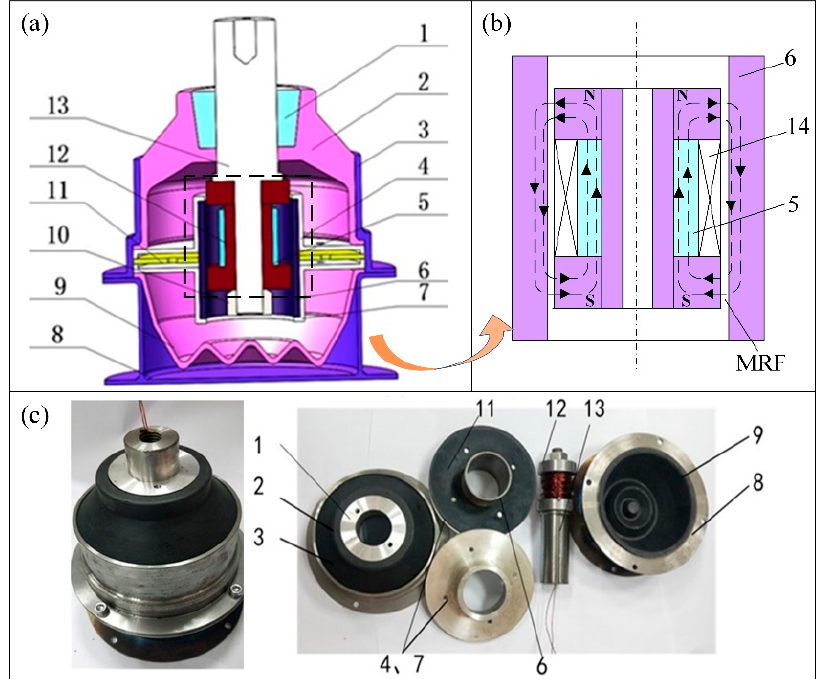
Figure 1. ( a ) Schematic diagram of magnetorheological suspension ( b ) magnetic circuit of magne- torheological suspension ( c ) physical map. 1 Reinforcing block; 2 rubber main spring; 3 upper cover; 4 upper piston chuck; 5 permanent magnet ring; 6 piston sleeve; 7 lower piston chuck; 8 lower cover; 9 rubber bottom film; 10 nuts; 11 decoupling film; 12 piston; 13 shafts; 14 coil.